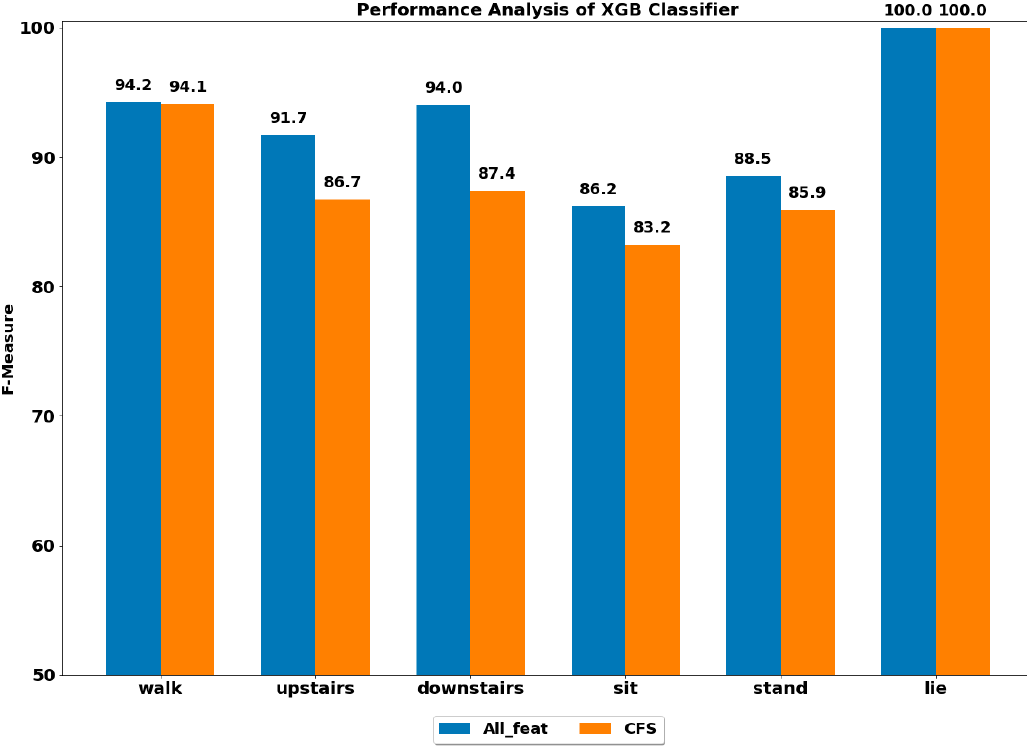
Figure 4. Performance analysis of LGBM (light gradient boosting Machine) classifier with and without feature selection to classify set of ADLs.